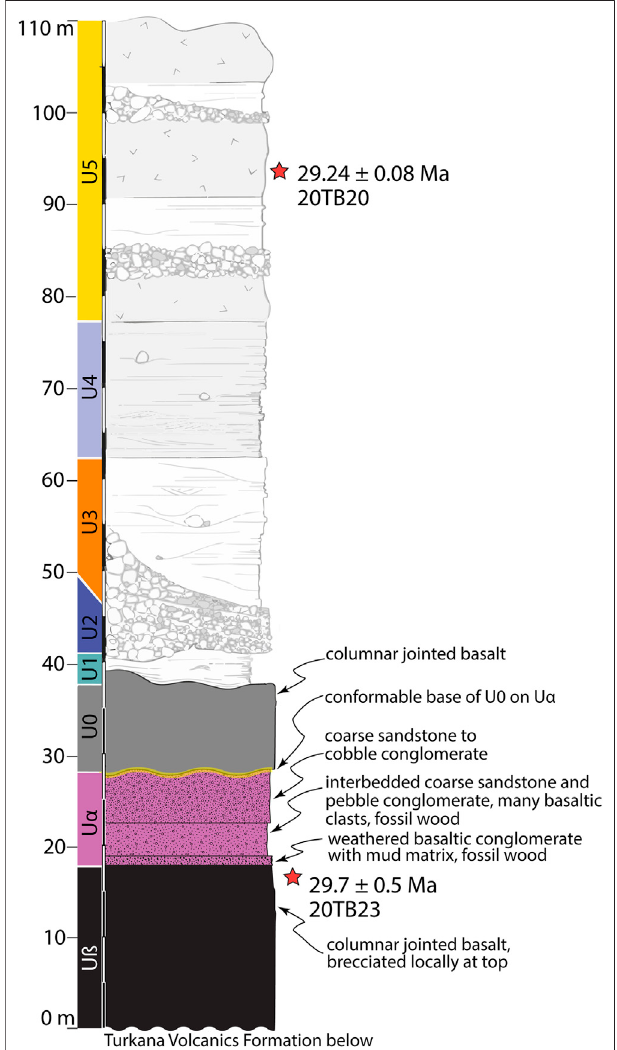
FIGURE 2 | Revised stratigraphy of the Topernawi Formation [after Ragonetal.(2019)].Yellowhighlightedcontactshowsnewlydiscoveredbasal conformity of U0 on U α ( fi eld photo in Figure 3C ). New sedimentary unit U α is pink. New basal unit Uß is black.